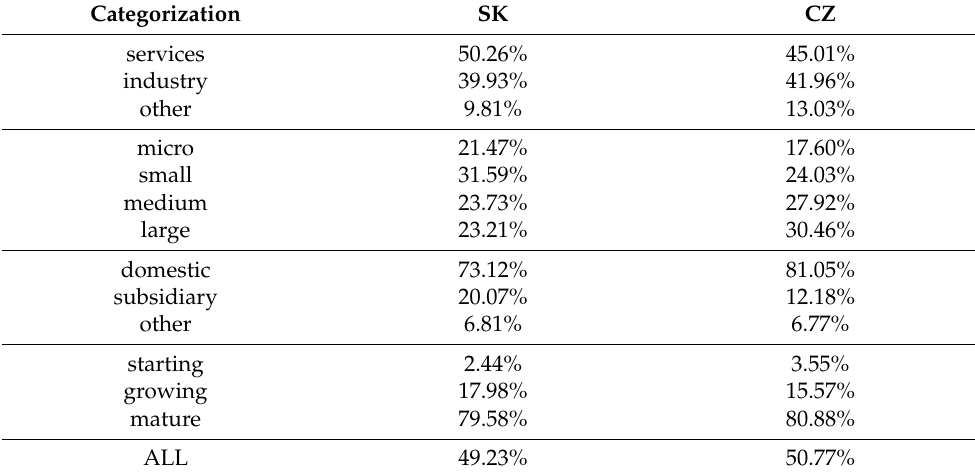
Table 1. Categorization of research sample (N =